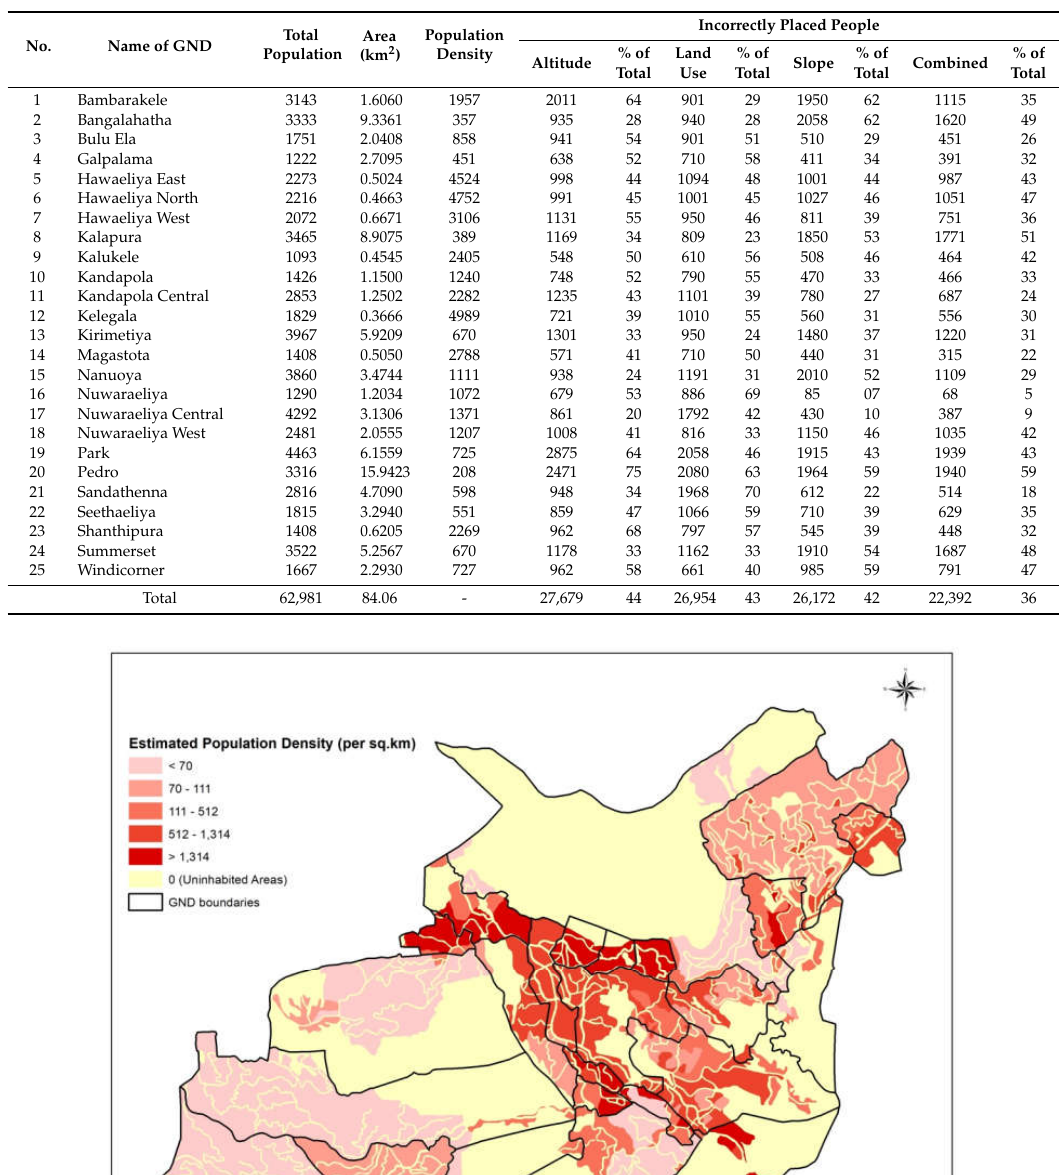
Table 2. Results of the HDM with various ancillary data.